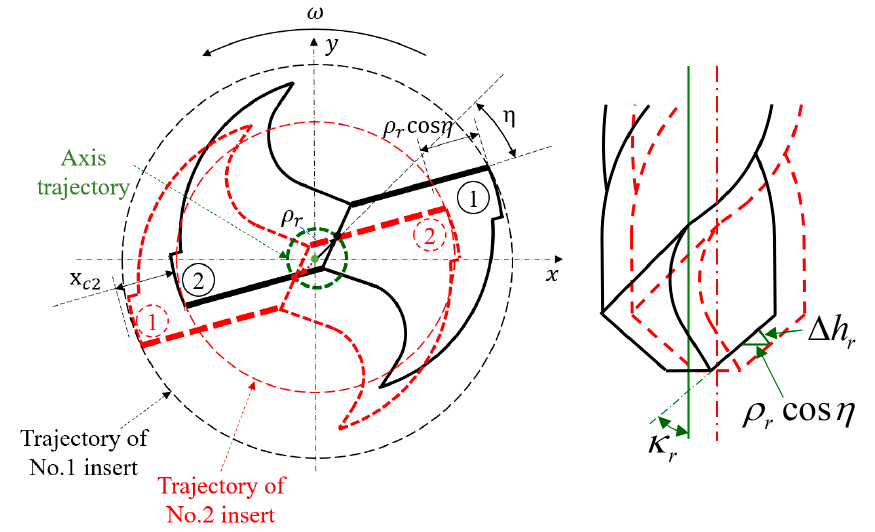
Figure 5. Insert position diagram caused by runout.